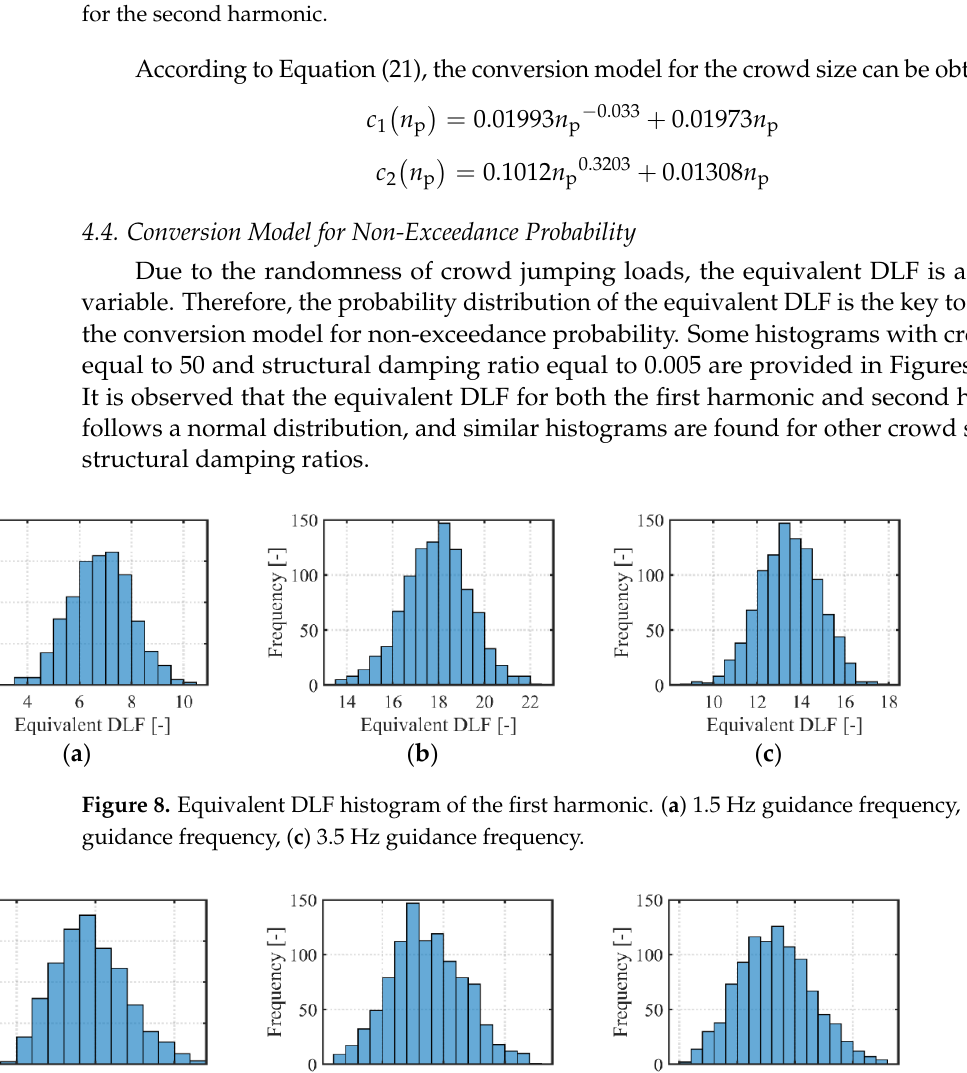
Figure 7. Conversion model for the coordination factor.